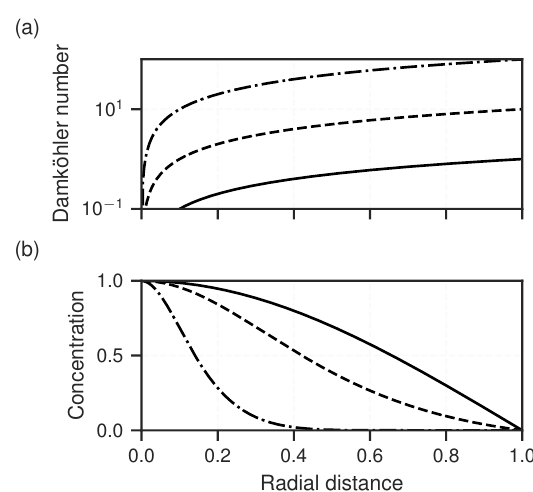
Figure 4. Dimensionless cases for the radial diverging flow scheme with Damköhler number ( a ) ranging 0–1 (solid), 0–10 (dashed) and 0–100 (dash-dotted) along the normalised horizontal flow axis. ( b ) Corresponding normalised steady-state solute